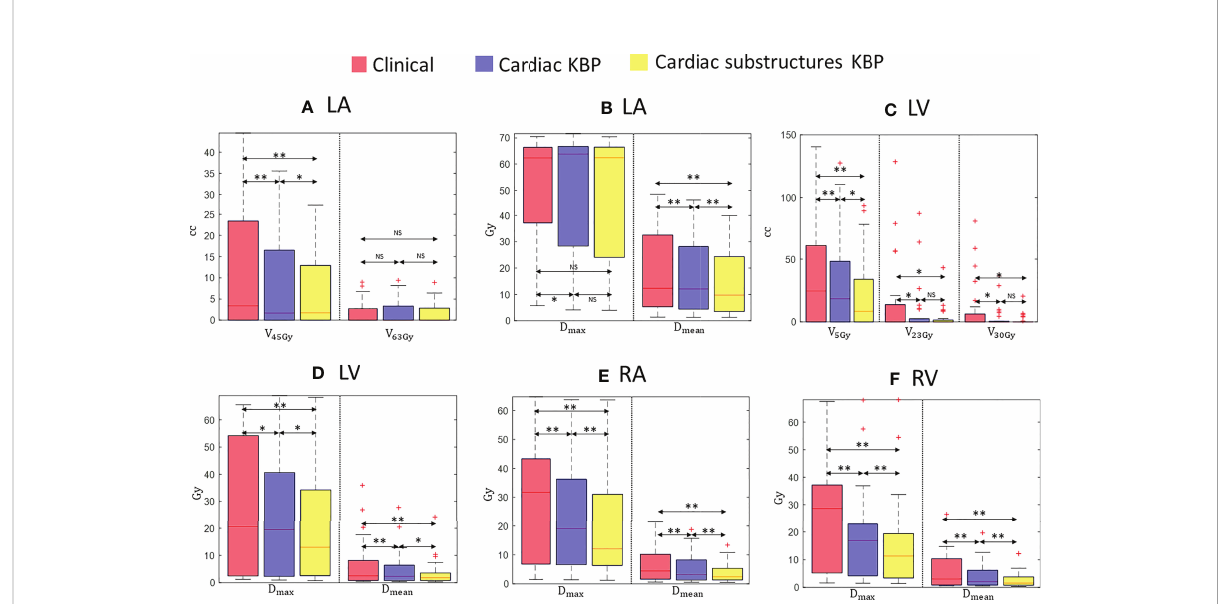
FIGURE 3 Box plots for clinically relevant dose volume metrics for LA (A, B) , LV (C, D) , RA (E) , and RV (F) over 28 treatment plans generated by clinically optimized (orange), CKBP (purple), and CS-KBP (yellow). The central mark indicates the median, and the bottom and top edges of the box indicate 25th and 75th percentile, respectively. The whiskers extend to the most extreme data points not considered outliers, and the outliers are plotted individually using the ‘ + ’ marker symbol. p < 0.05 is denoted as ‘ * ’ ; p < 0.01 is denoted as ‘ ** ’ ; NS = Not Signi fi